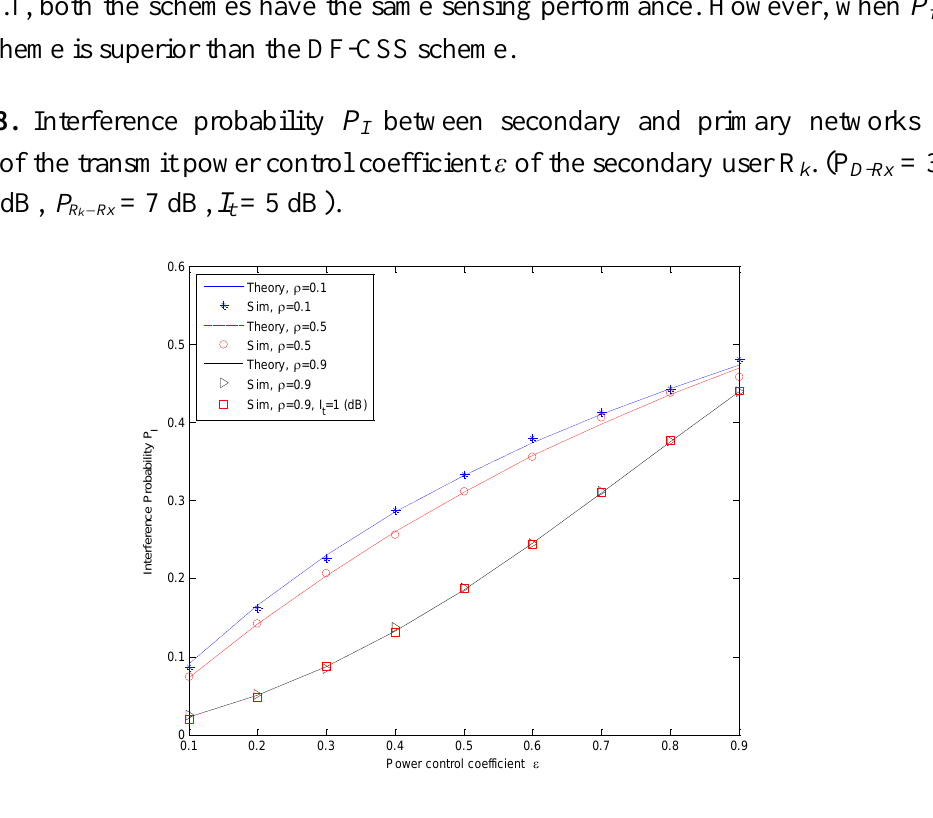
between secondary and primary networks as a I